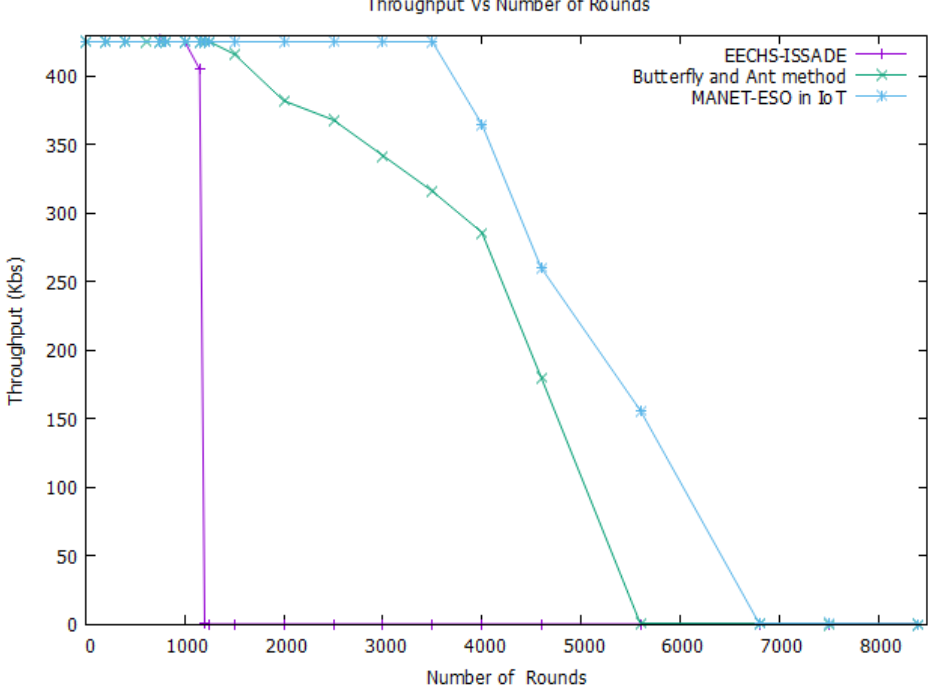
Figure 4. Throughput vs. number of rounds.